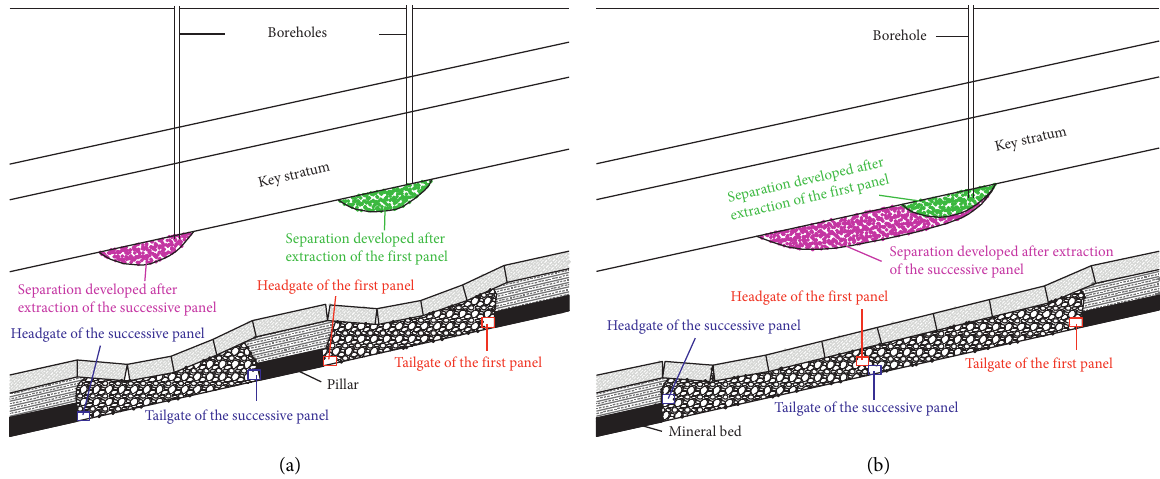
Figure 11: Overburden grout injection [25]. (a) Independent overburden grout injection. (b) Continuous overburden grout injection.